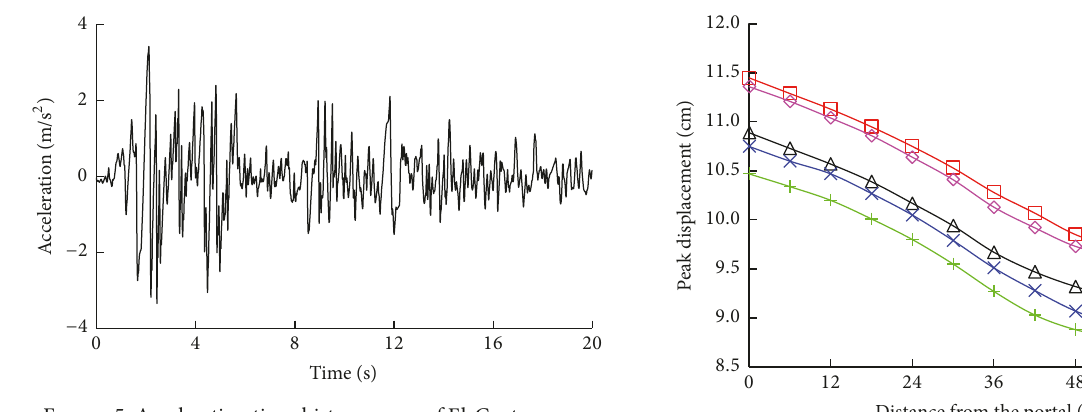
Figure 5: Acceleration time-history curve of El-Centro wave.